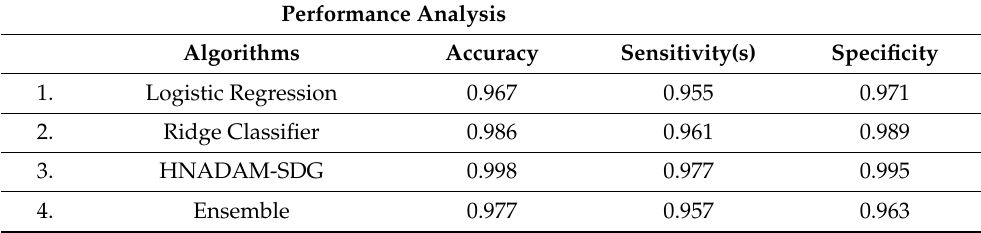
Table 5. Performance